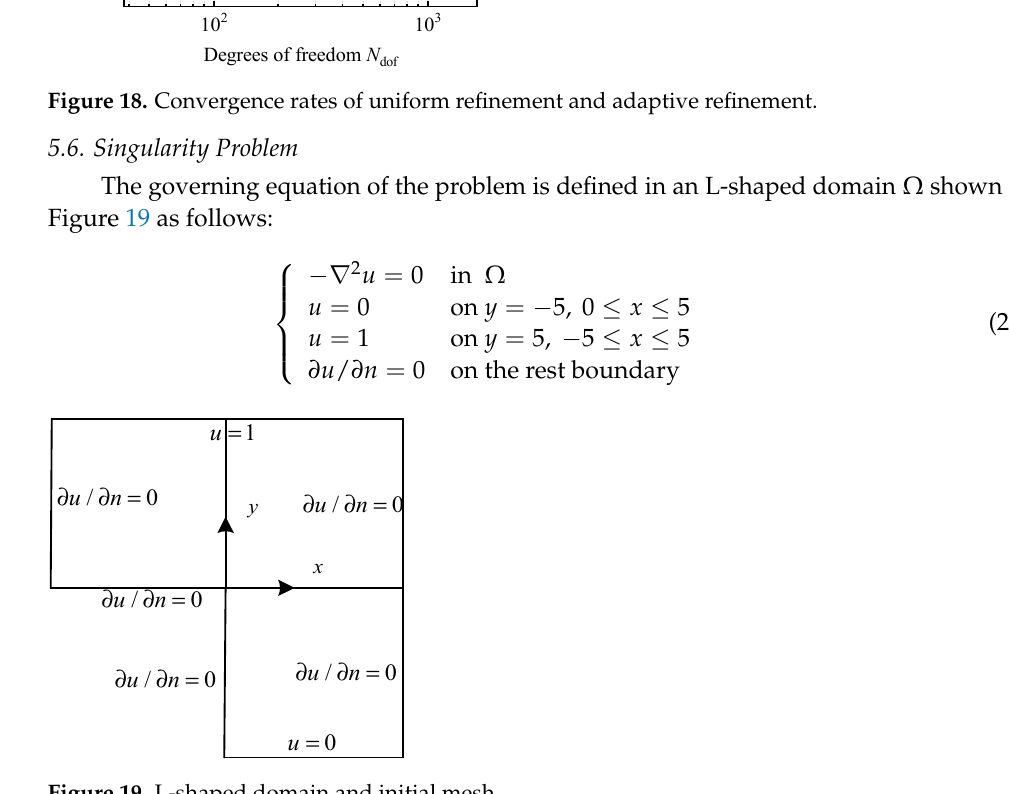
Figure 18. Convergence rates of uniform refinement and adaptive refinement.